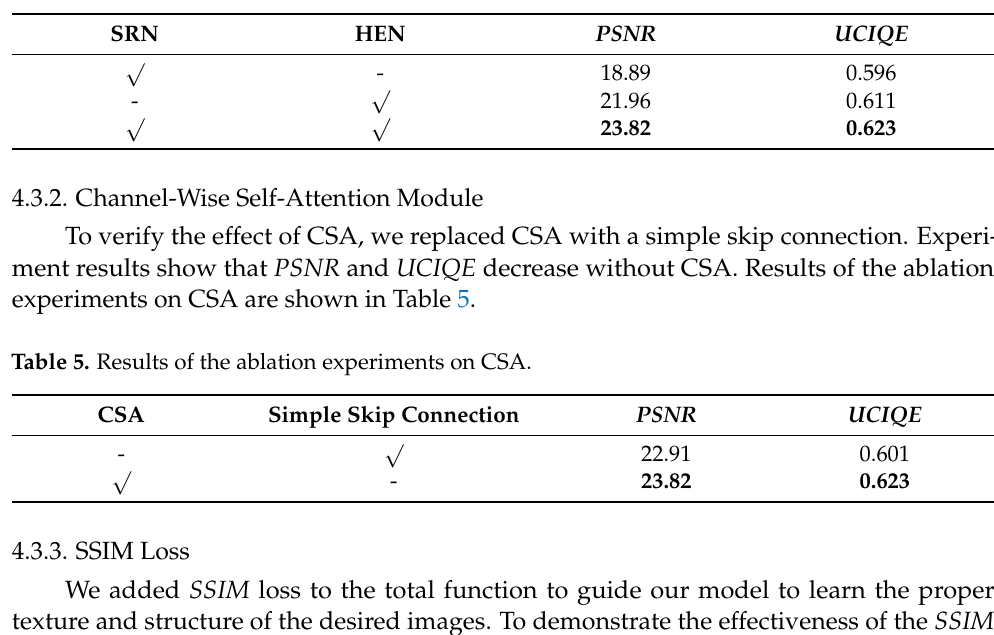
Table 4. Results of the ablation experiments on the two-stage network.